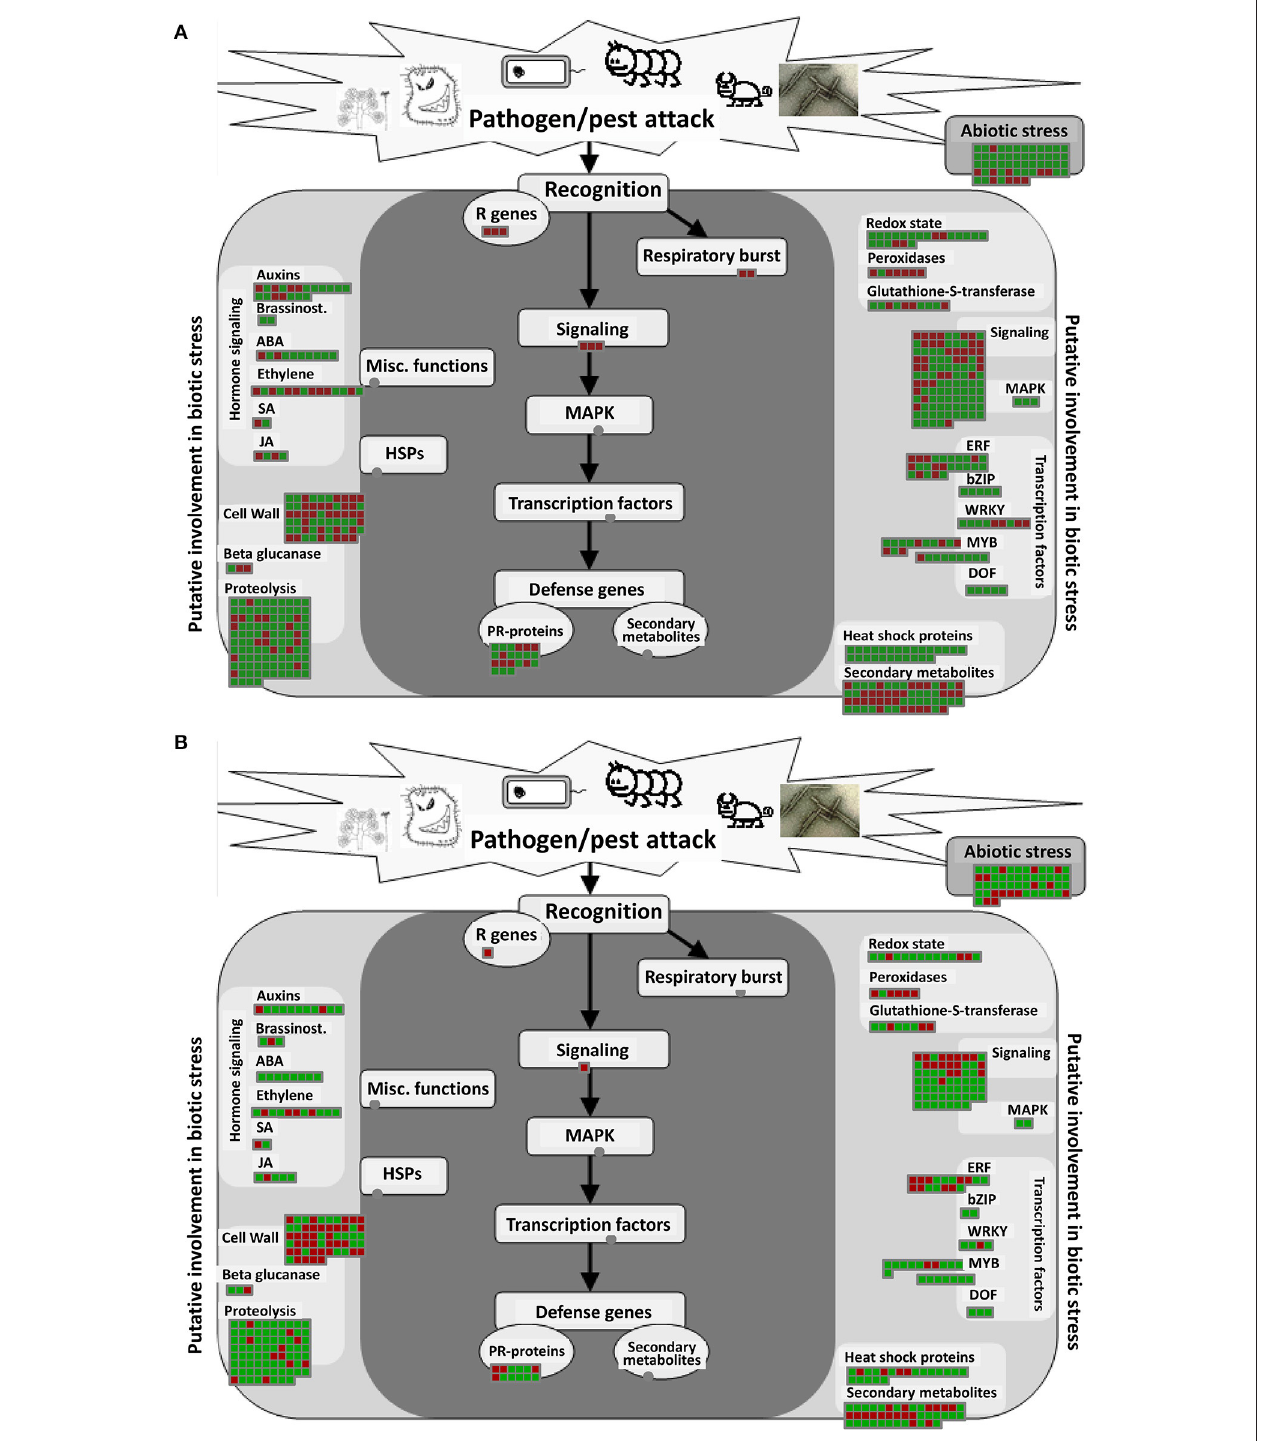
FIGURE 4 | Biotic stress pathway analyses of DEGs in A. thaliana during early infection by P. brassicae. Analysis of the biotic stress pathway of DEGs was performed using MAPMAN software. Red boxes mean up-regulated genes and green mean down-regulated genes. (A) 24 h after inoculation; (B) 48 h after inoculation. The pathway frames are from the MAPMAN software